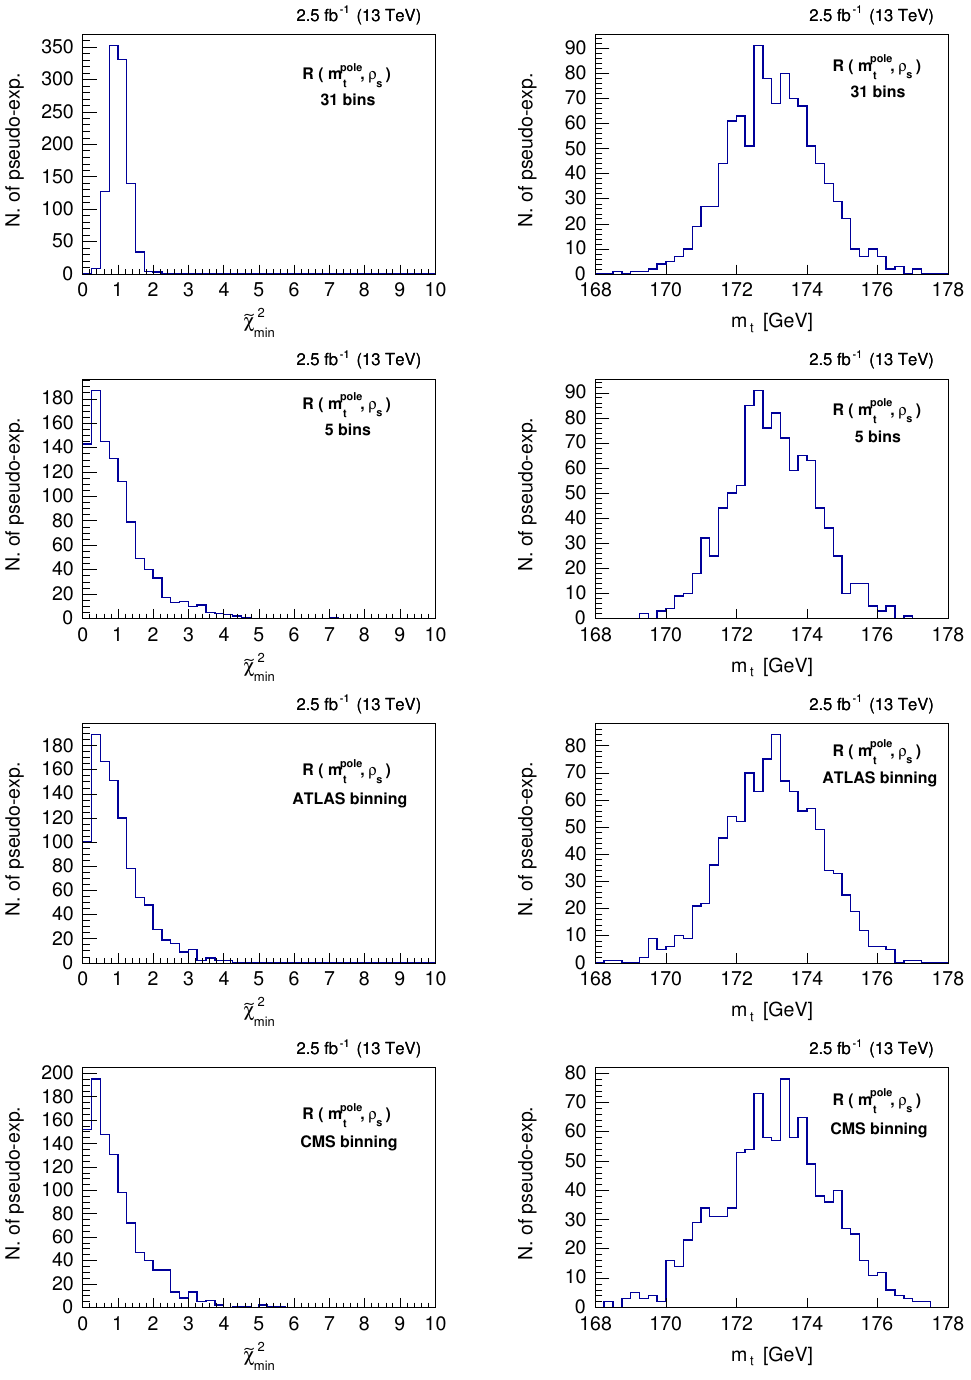
Figure 9 . Distribution of minimum ~ (cid:31) 2 ( (cid:31) 2 =d:o:f: ) and of the corresponding top quark mass (cid:17) from 1000 pseudo-experiments. Luminosity of = 2 : 5 fb (cid:0) 1 is assumed. Results are shown for full L theory for the pp e + (cid:23) e (cid:22) (cid:0) (cid:22) (cid:23) (cid:22) b (cid:22) bj + X production process at the LHC with p s = 13 TeV. The ! CT14 PDF set and (cid:22) 0 = H T = 2 are